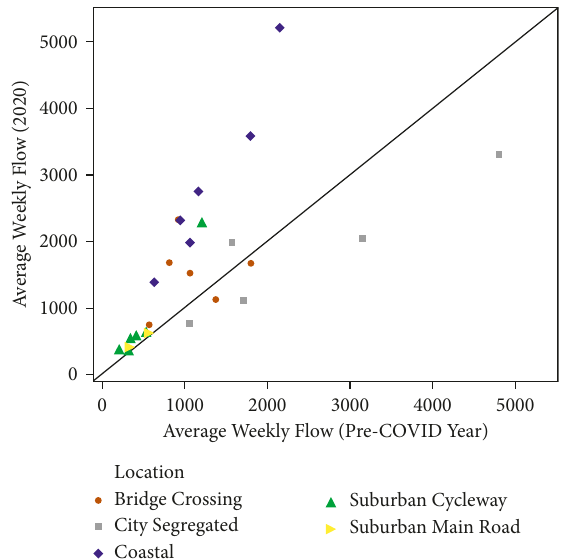
Figure 2: Change in average weekly flow pre/during